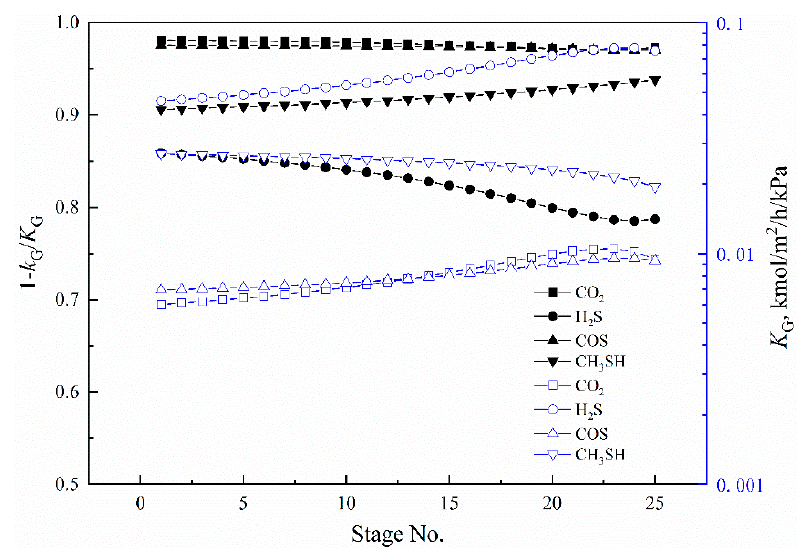
Figure 11. Total mass transfer coefficient and mass transfer resistance of different column positions (overflow weir height: 0.15 m; absorption pressure: 6 Mpa; inlet gas flow rate: 5.0 × 10 6 Nm 3 /d; inlet gas–liquid ratio: 600; inlet gas loading: CO 2 , 4.5 vol.%; H 2 S, 1.5 vol.%; COS, 15 mg/m 3 ; CH 3 SH, 15 mg/m 3 ).